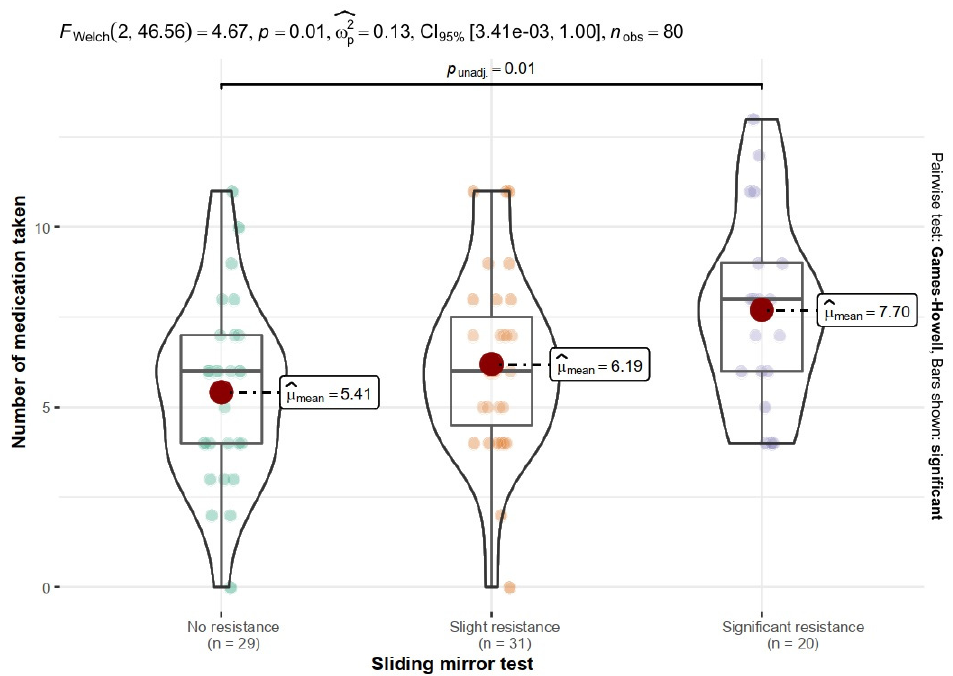
Figure 3. Relationship between the number of medications taken and the score of the sliding mirror test. Fisher’s exact test and post-hoc test.